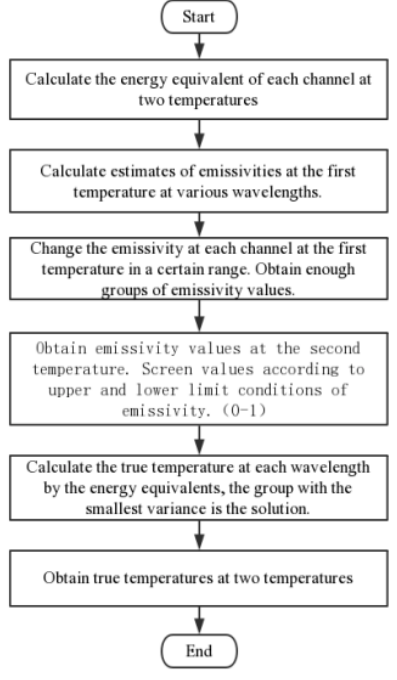
Figure 1. A flow chart of the secondary measurement method.